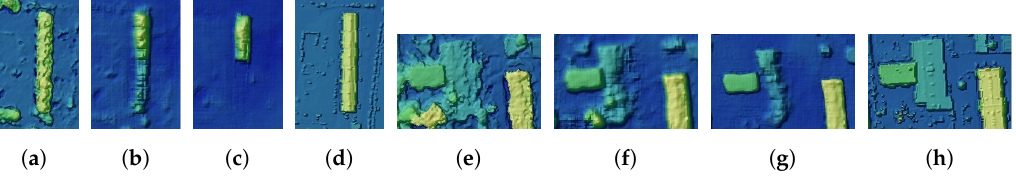
Figure 10. Example of two buildings generated by the LIDAR-DSM setup ( b , f ) and LoD2-DSM setup ( c , g ), respectively. ( a , e ) show the buildings on stereo DSM and ( d , h ) on LIDAR DSM ground truth data. The depicted examples are from the Munich